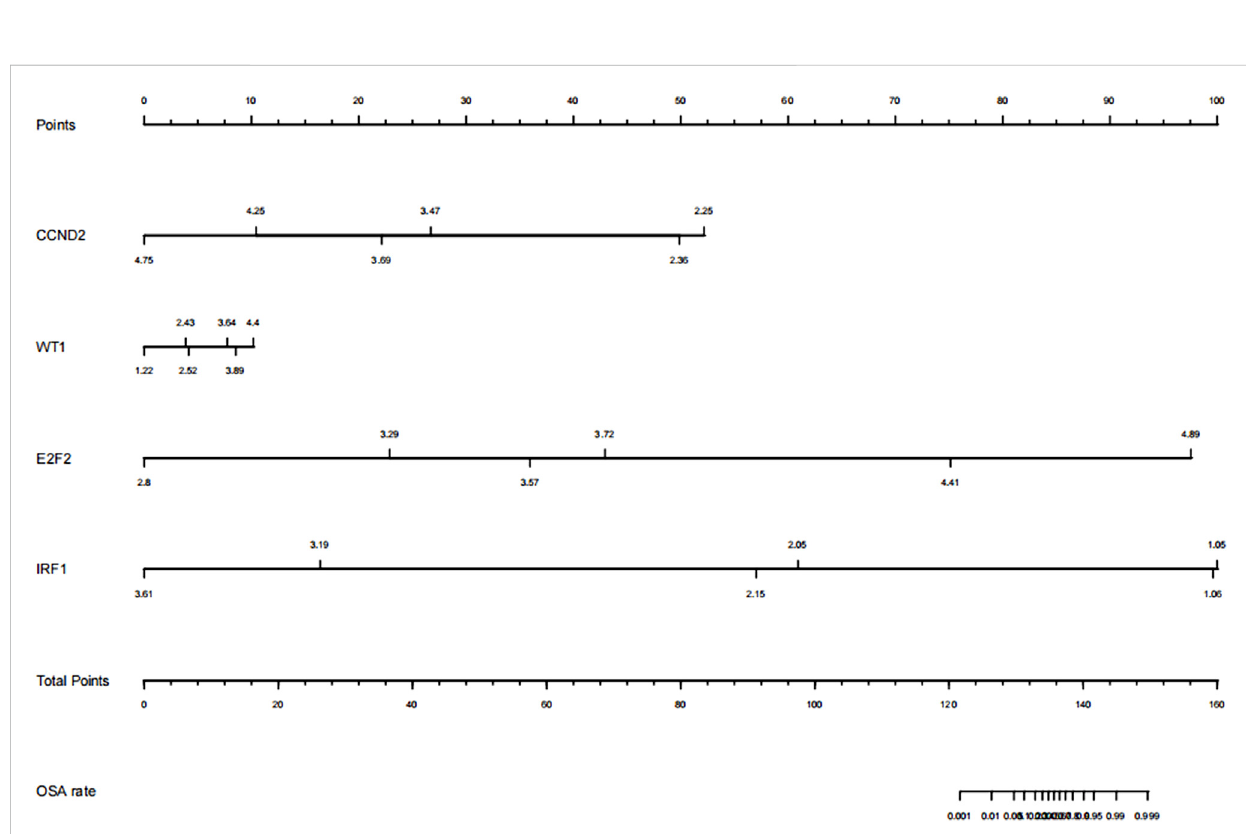
FIGURE 10 Nomogram for predicting obstructive sleep apnea syndrome. OSA: obstructive sleep